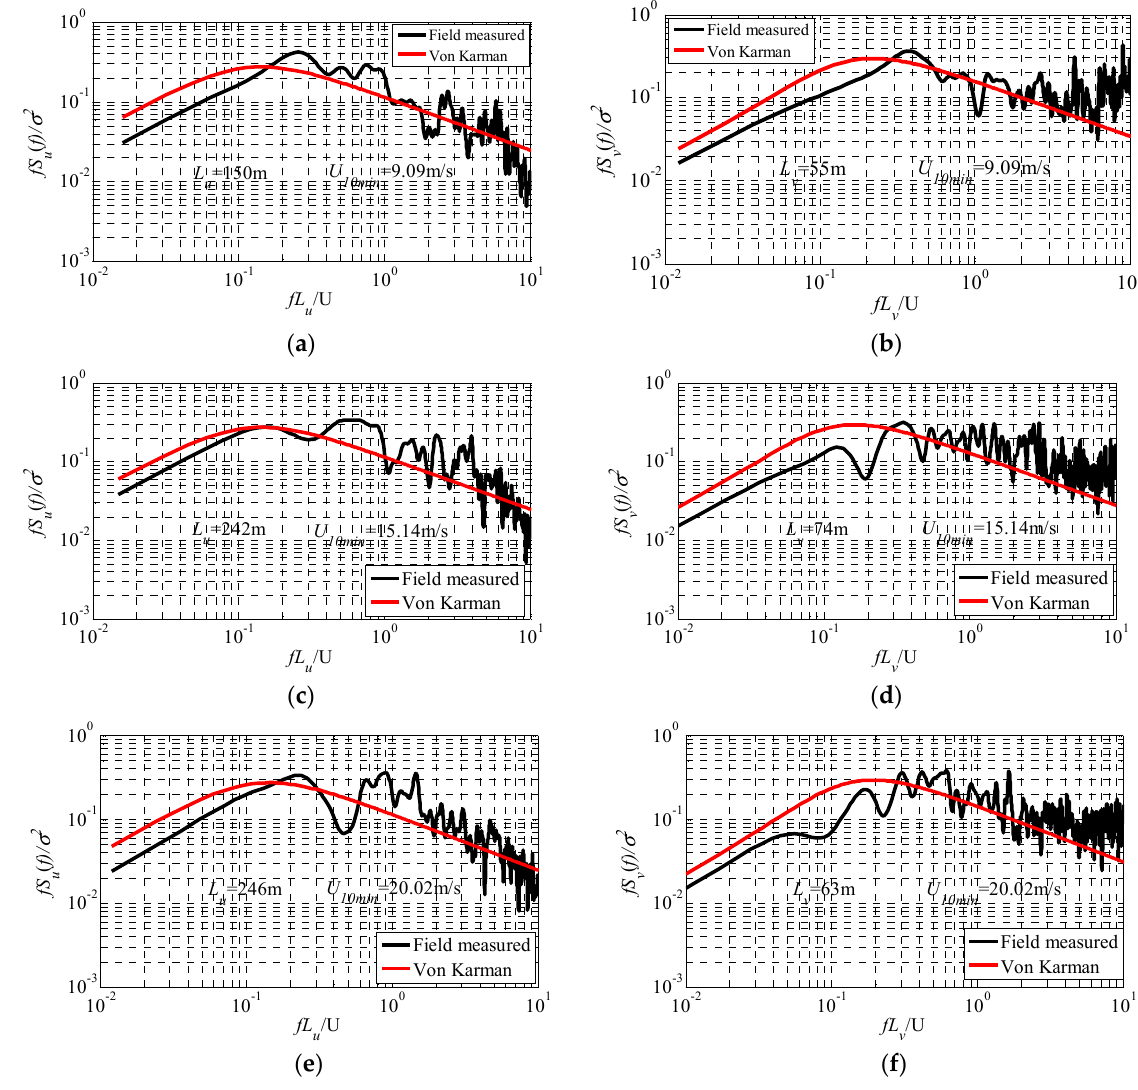
Figure 12. Power spectrum of wind speed during Typhoon Sarika. ( a ) U ( b ) U 10min = 9.09 m/s; L v = 55 m; ( c ) U 10min = 15.14 m/s; L u = 242 m; ( d ) U 10min = 15.14 m/s; L v = 74 m; ( e ) U 10min = 20.02 m/s; L u = 246 m; ( f ) U 10min = 20.02 m/s; L v = 63